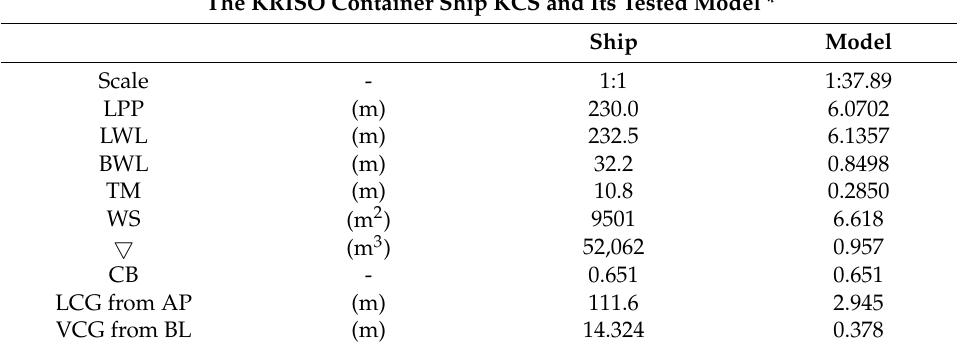
Table 2. Main particulars and floating conditions of the KRISO containership. The KRISO Container Ship KCS and Its Tested Model *